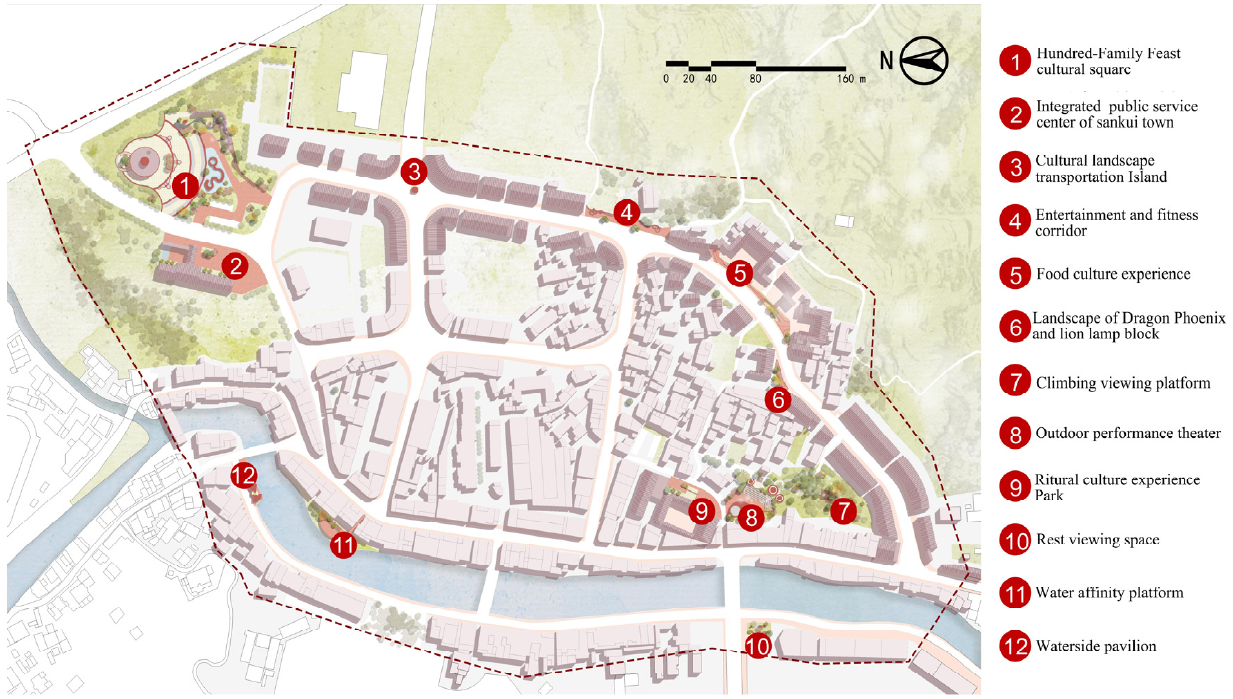
Figure 6. General layout of Taishun Hundred-family Feast landscape presentation.